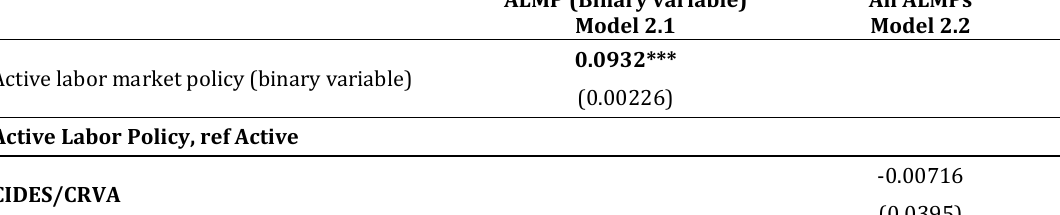
All ALMPs Model